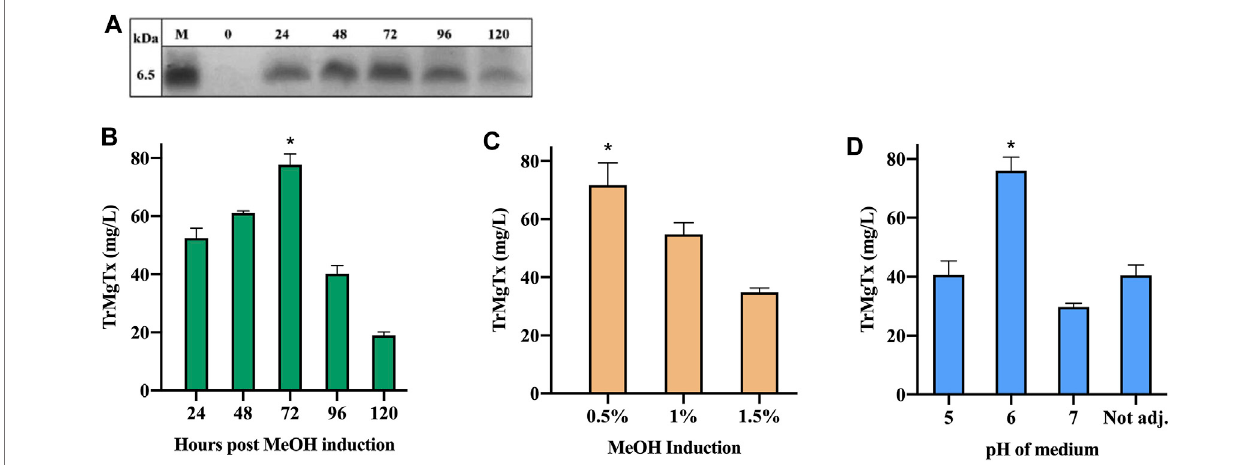
FIGURE2 | Optimization of TrMgTx expression in shake- fl ask fermentation. (A) 15 µl of supernatant sampleswere collected at indicated time points and analyzed by using 16% tricine – SDS-PAGE (stained with R-250 CBB). The samples from 24 to 120 h show bands of ∼ 6.5 kDa (close to the estimated MW of TrMgTx). (B) Concentration of TrMgTx in supernatant was quanti fi ed at the indicated time points by comparing the gel band intensity of TrMgTx with that of the standards by using Image Lab software (Bio-Rad). Expression was induced by 0.5% methanol at pH (cid:1) 6.0 of the medium. (C) Secretion of TrMgTx in culture (at pH 6) induced with different MeOH concentrations for 72 h, peptide concentration was determined as in ( A ). (D) TrMgTx expression was determined as in (A) when induced with 0.5% MeOH for 72 h at the indicated pH values of the medium. Label “ Not adj. ” means that the pH of the medium was not buffered. Data represent the mean of three independent experiments, where the error bars are SEM. Asterisks indicate signi fi cant difference in all pairwise multiple comparison (Tukey ’ s test), * p < 0.05.